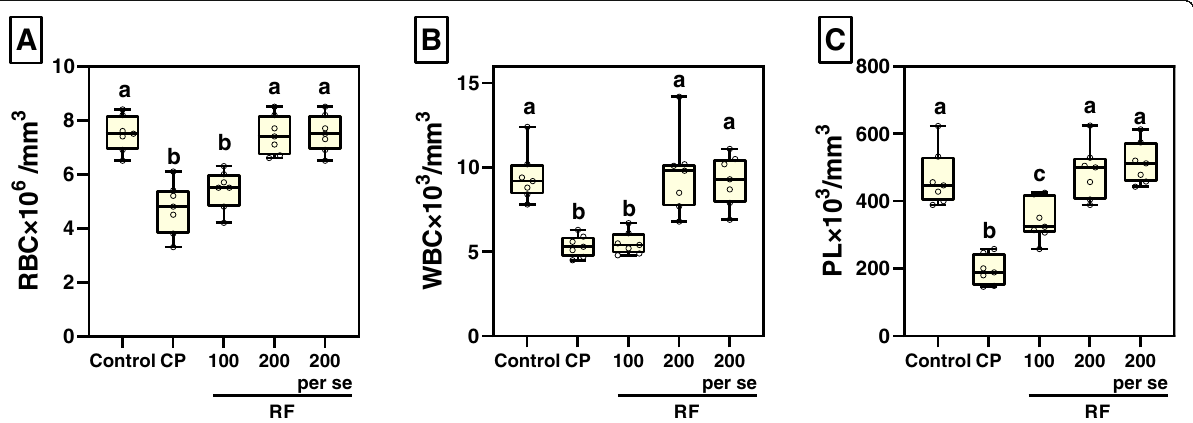
Fig. 1 The effect of RF on the number of blood RBC ( a ), WBC ( b ), and PL ( c ). Results are expressed as group median (min, max) and analyzed by ANOVA or Kruskal – Wallis, followed by the Tukey or Dunn posttests, respectively (n = 7). Different small letters in the box indicate the significance of differences at P < 0.05. Abbreviations: RBC: red blood cell, WBC: white blood cell, PL: